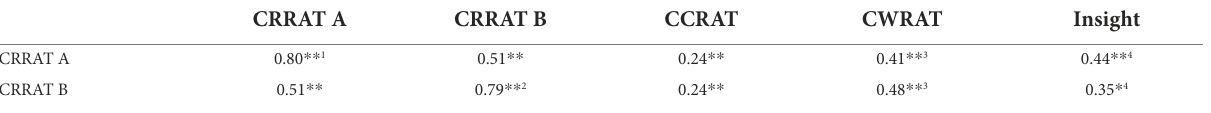
TABLE 6 Criterion-related validity of CRRAT scores.